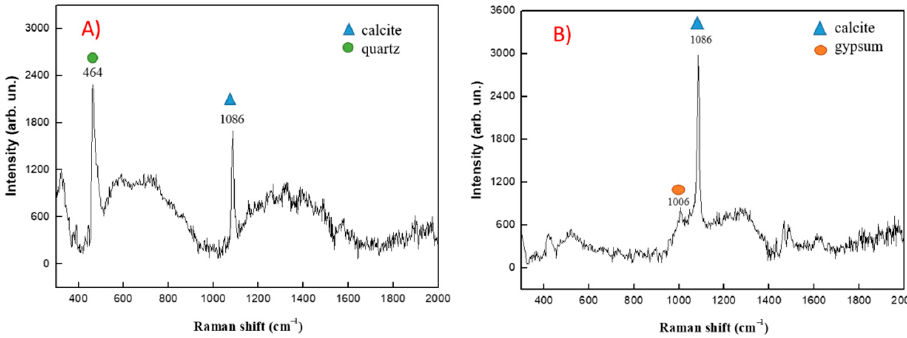
Figure 23. Raman spectra of pink pigment; ( A ) in situ, point 7; ( B ) sample.